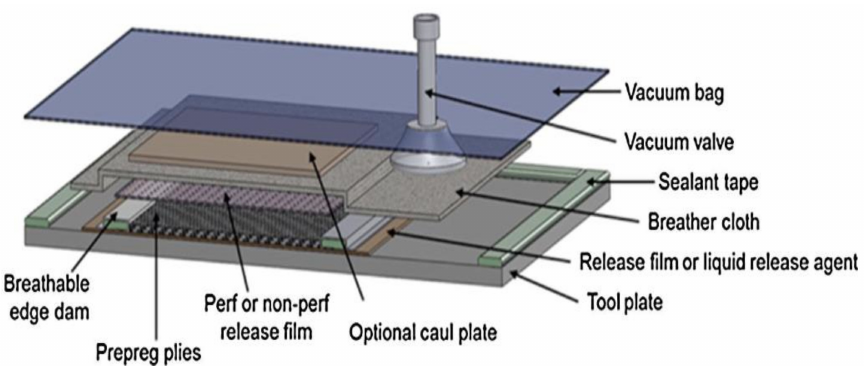
Figure 5. Manufacturing assembling of VBO cure [21]. Reprinted with permission from